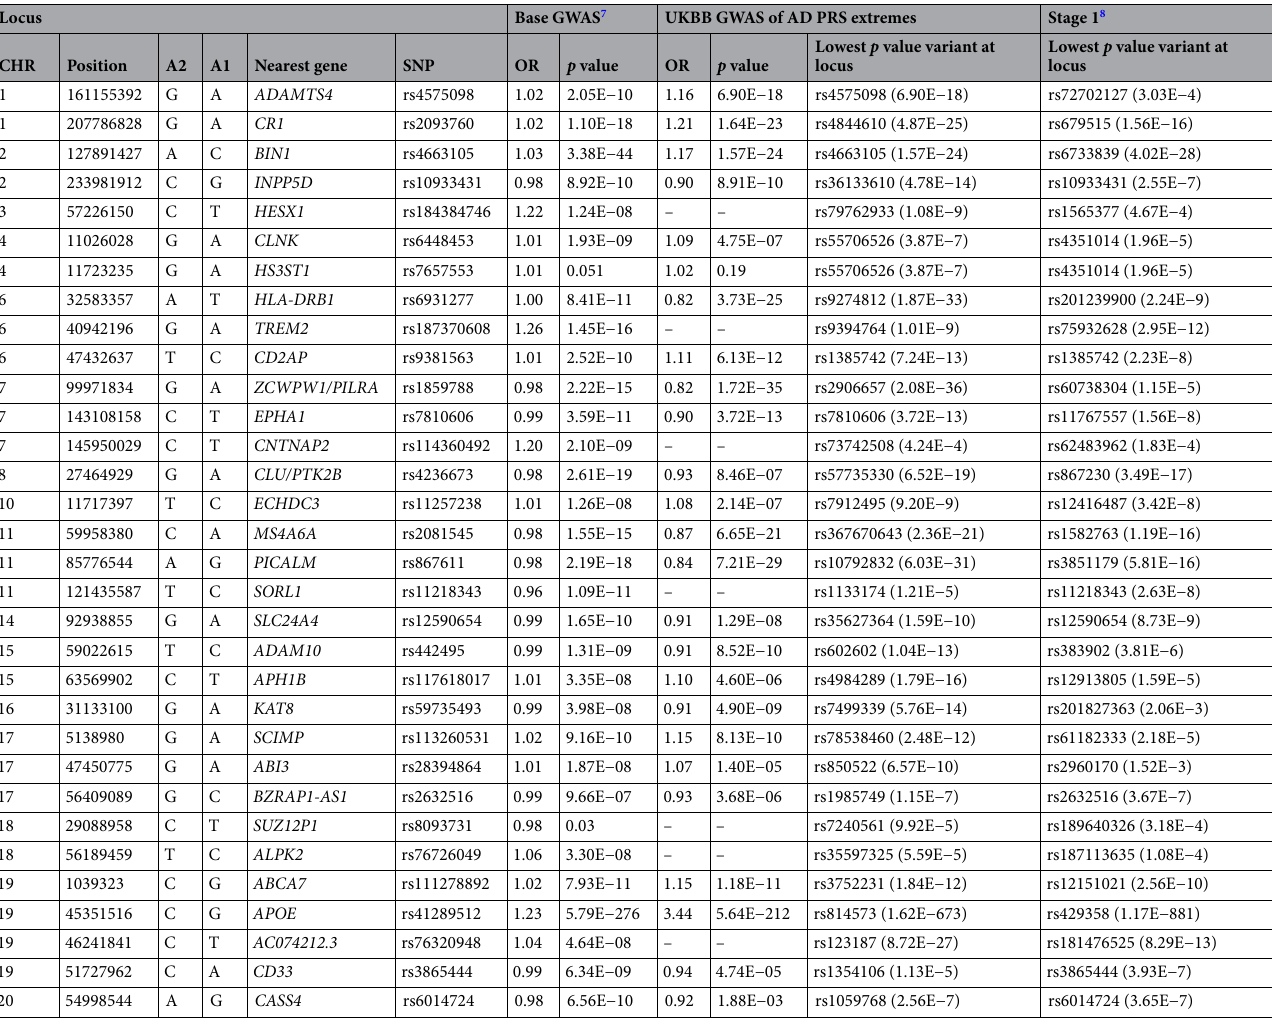
Table 2. Significant variants reported by Ref. 7 . Lowest p value columns are defined as 500 kb flanking the original reported variant. SNP positions are in